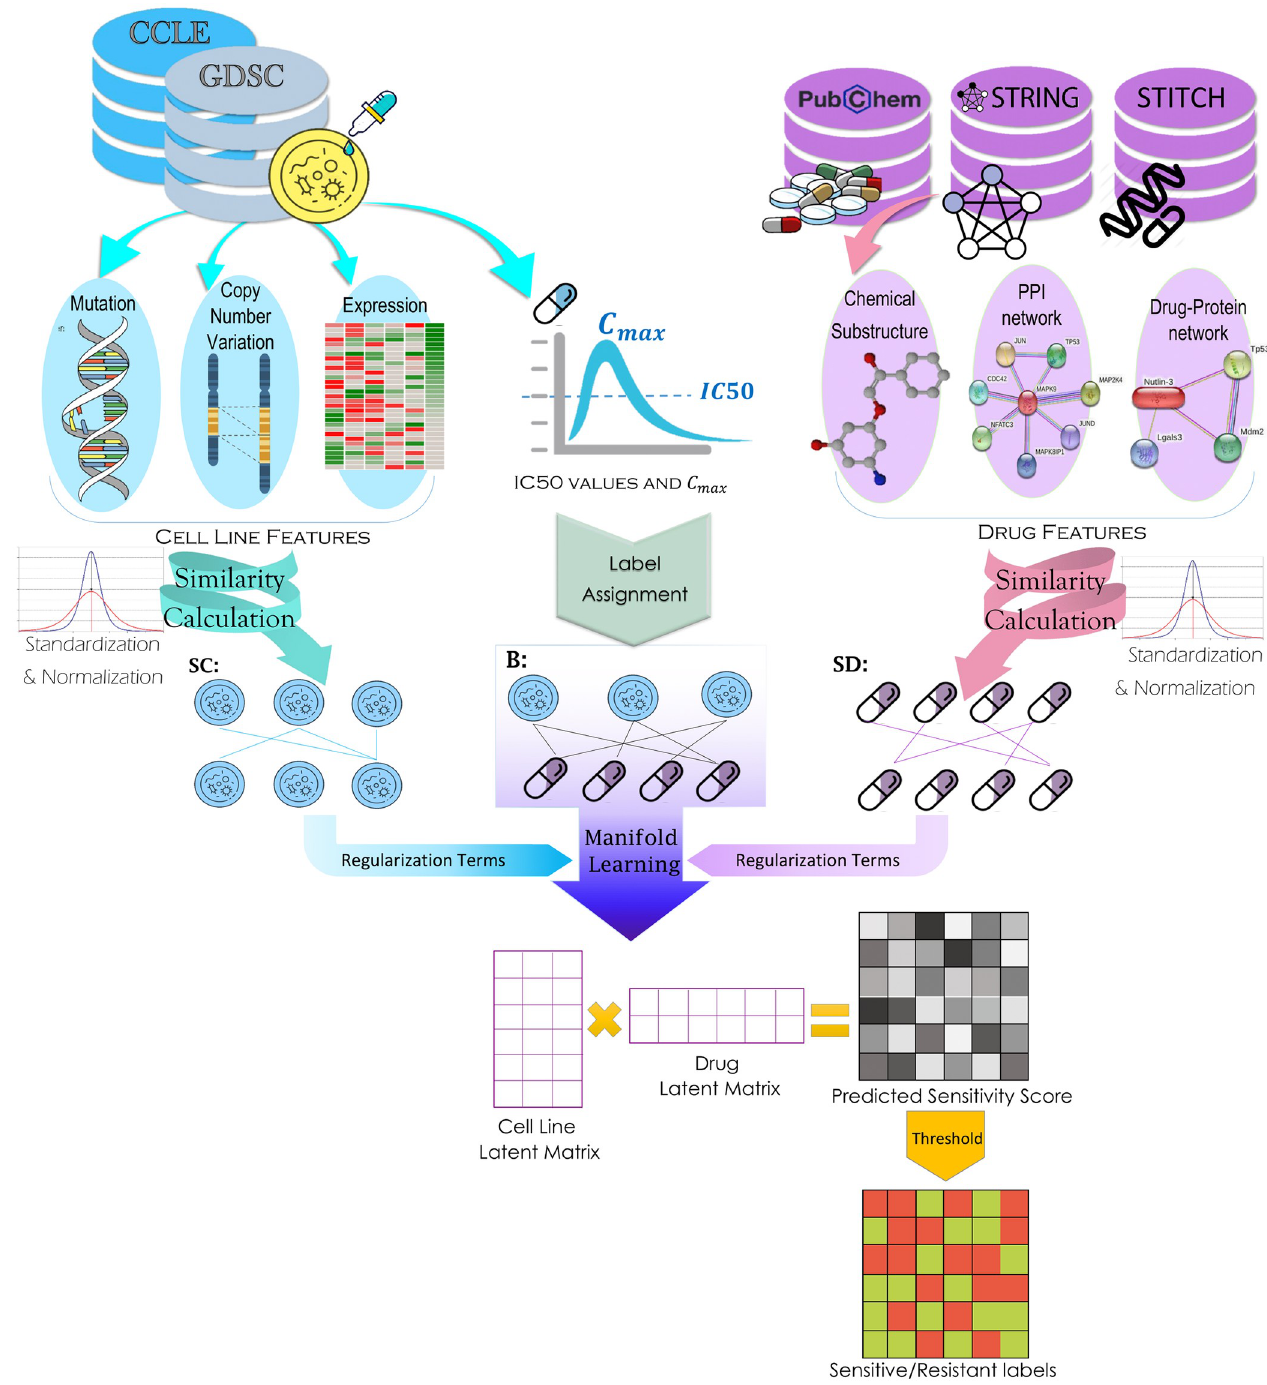
Fig 4. The overall framework of the proposed method. The features cell lines, IC50 and C max values were obtained from GDSC. Besides, drug substructures were downloaded from PubChem, STiTH network from STiTCH datbase, and PPI network from STRING database. The sensitivity associations between cell line-drug pairs were specified and used as the objective of manifold learning. The cell line similarities and drug similarities were calculated, standardized, and normalized. These similarities were considered as the regularization terms in manifold learning. The output of manifold learning is a predicted score matrix that assigns cell line-drug pairs into sensitive resistant classes by a